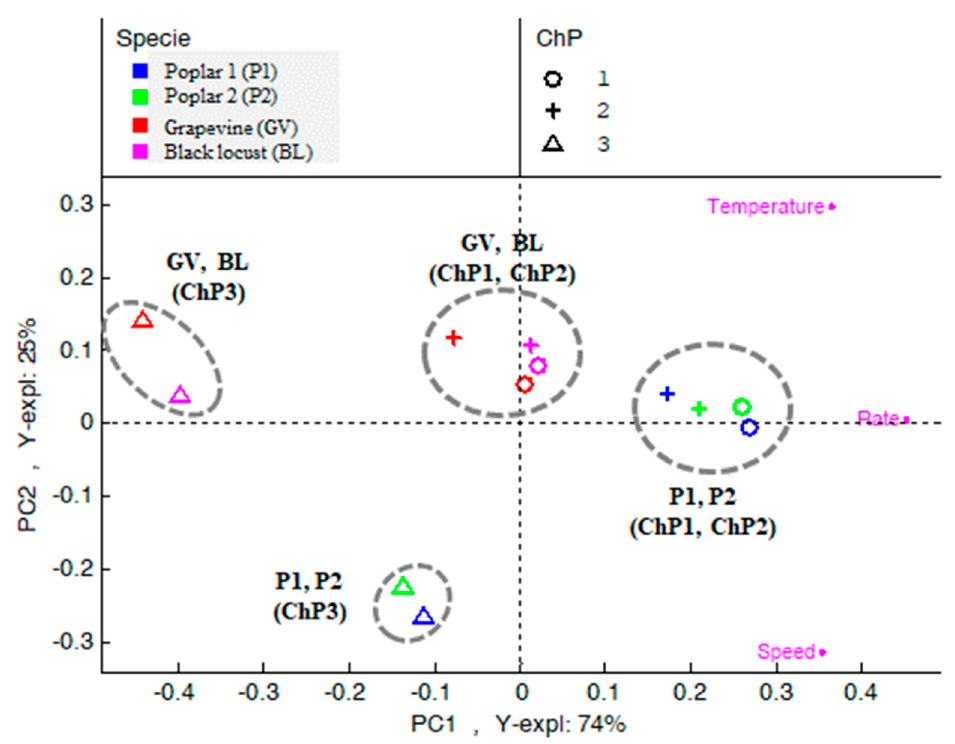
Figure 7. Principal component analysis of the thermodynamic variables monitored during the drying of the wood chips of poplar, grapevine and black locust.